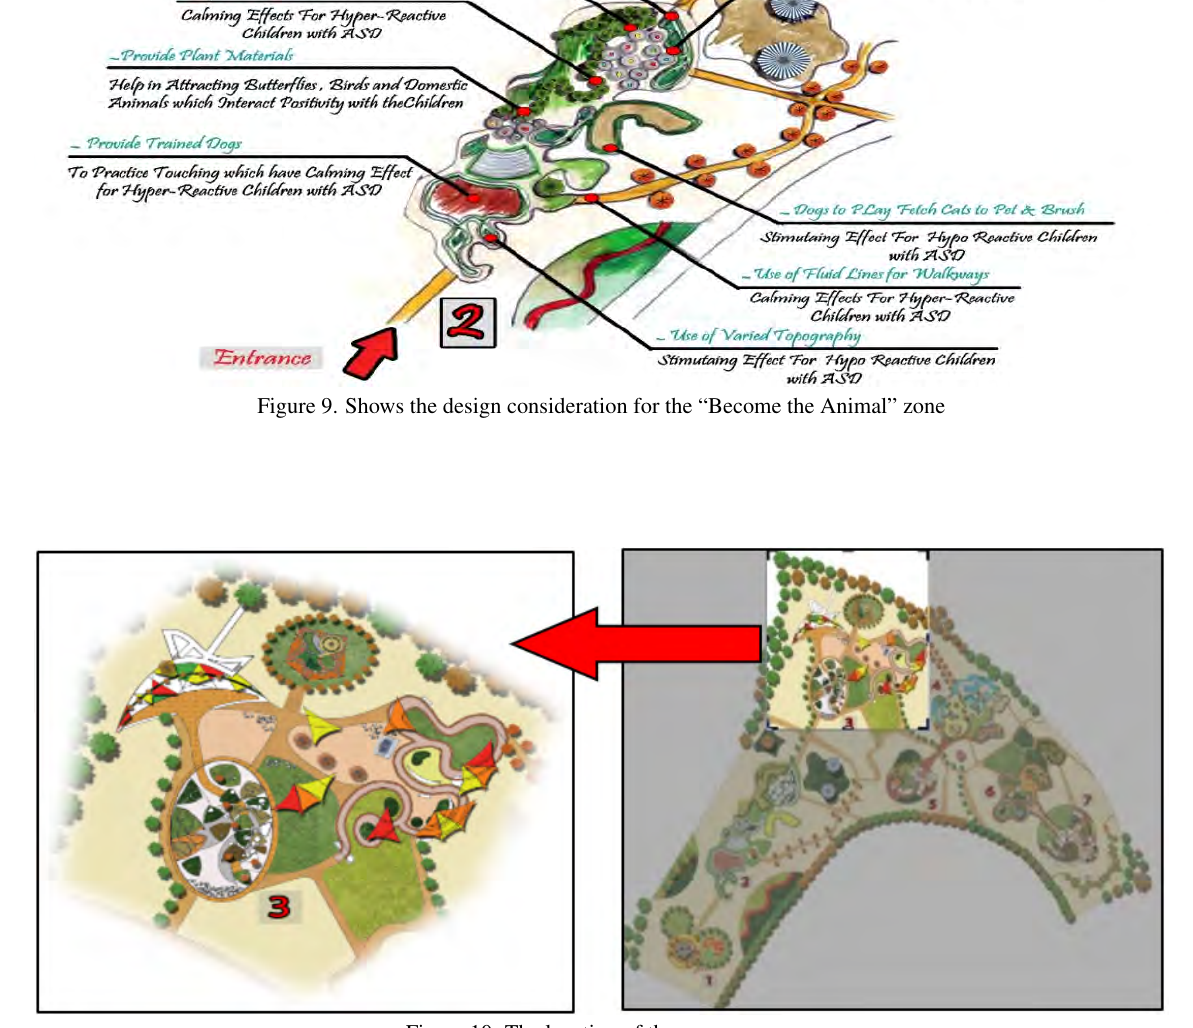
Figure 10. The location of the sensory zone